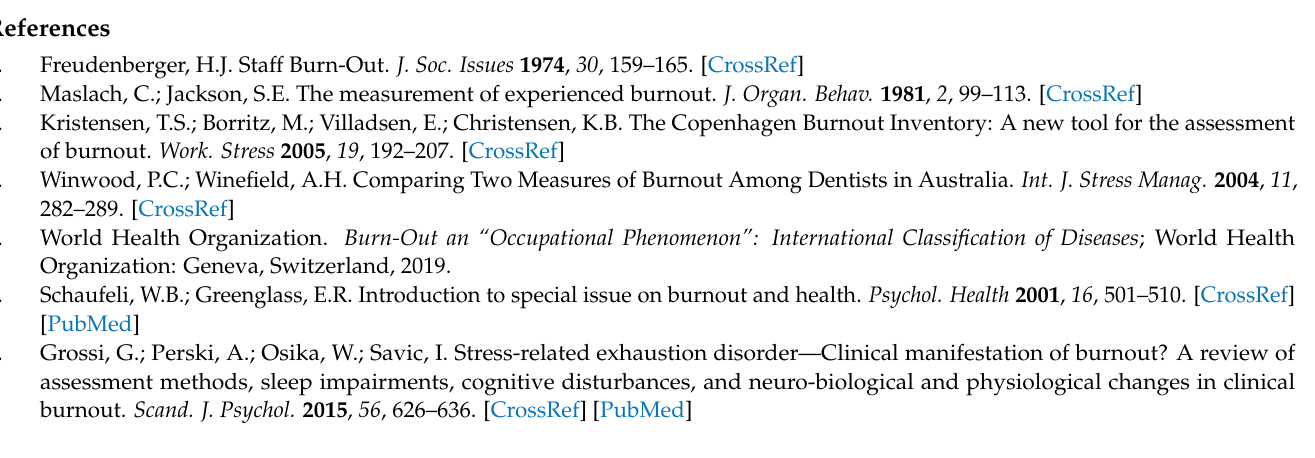
Table S2: The 13 items for the PB and WB scales; Table S3: Musculoskeletal Pain Sites and Factor Analysis of the Nordic Musculoskeletal Questionnaire; Table S4: The formulates for testing on mediation